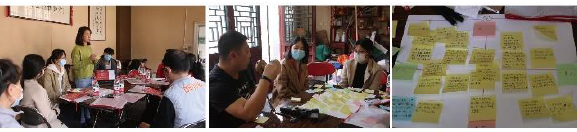
Figure 3. Design Workshop. Source: "Warm Inheritors"